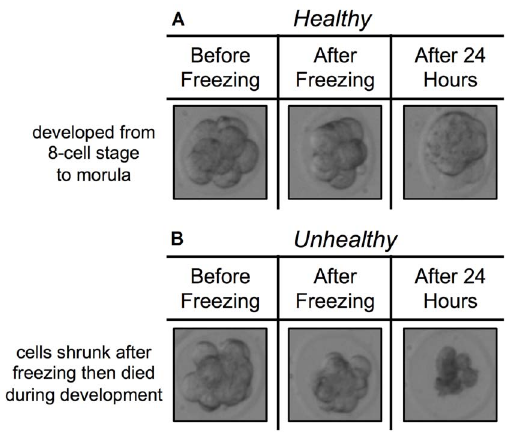
Figure 4. Healthy and unhealthy embryo morphology before and after freezing, and after 24 hours culturing. (A) Healthy and (B) unhealthy examples showing morphology changes before and after freezing. Survival rate was determined on the basis of embryo morphology after thawing vitrified embryos. Cell leakage, abnormal shapes, and membrane damage, as commonly used in vitrification studies, were counted as failure cases. Development rate was quantified by the embryo stage reached after culturing. For instance, the 8-cell stage embryo shown in (A) after vitrification, thawing, and culturing successfully developed to the blastocyst stage.